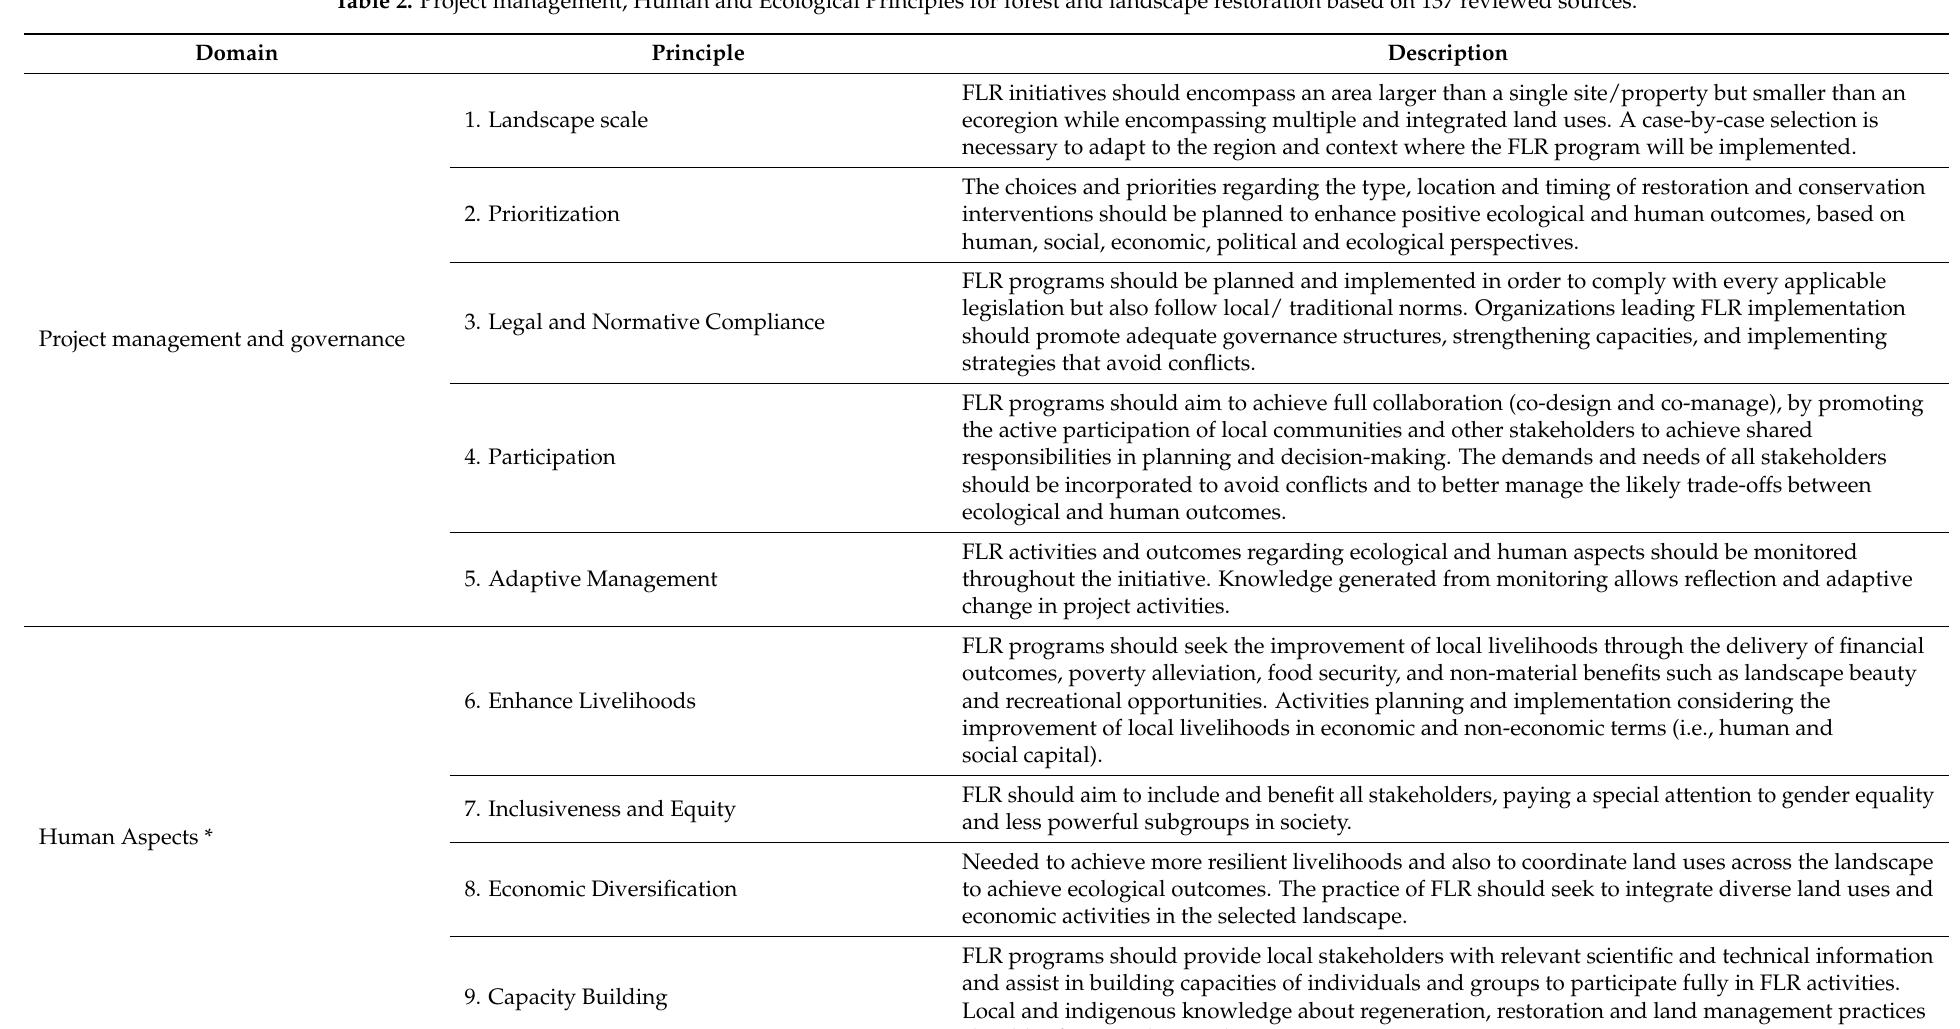
Table 2. Project management, Human and Ecological Principles for forest and landscape restoration based on 137 reviewed